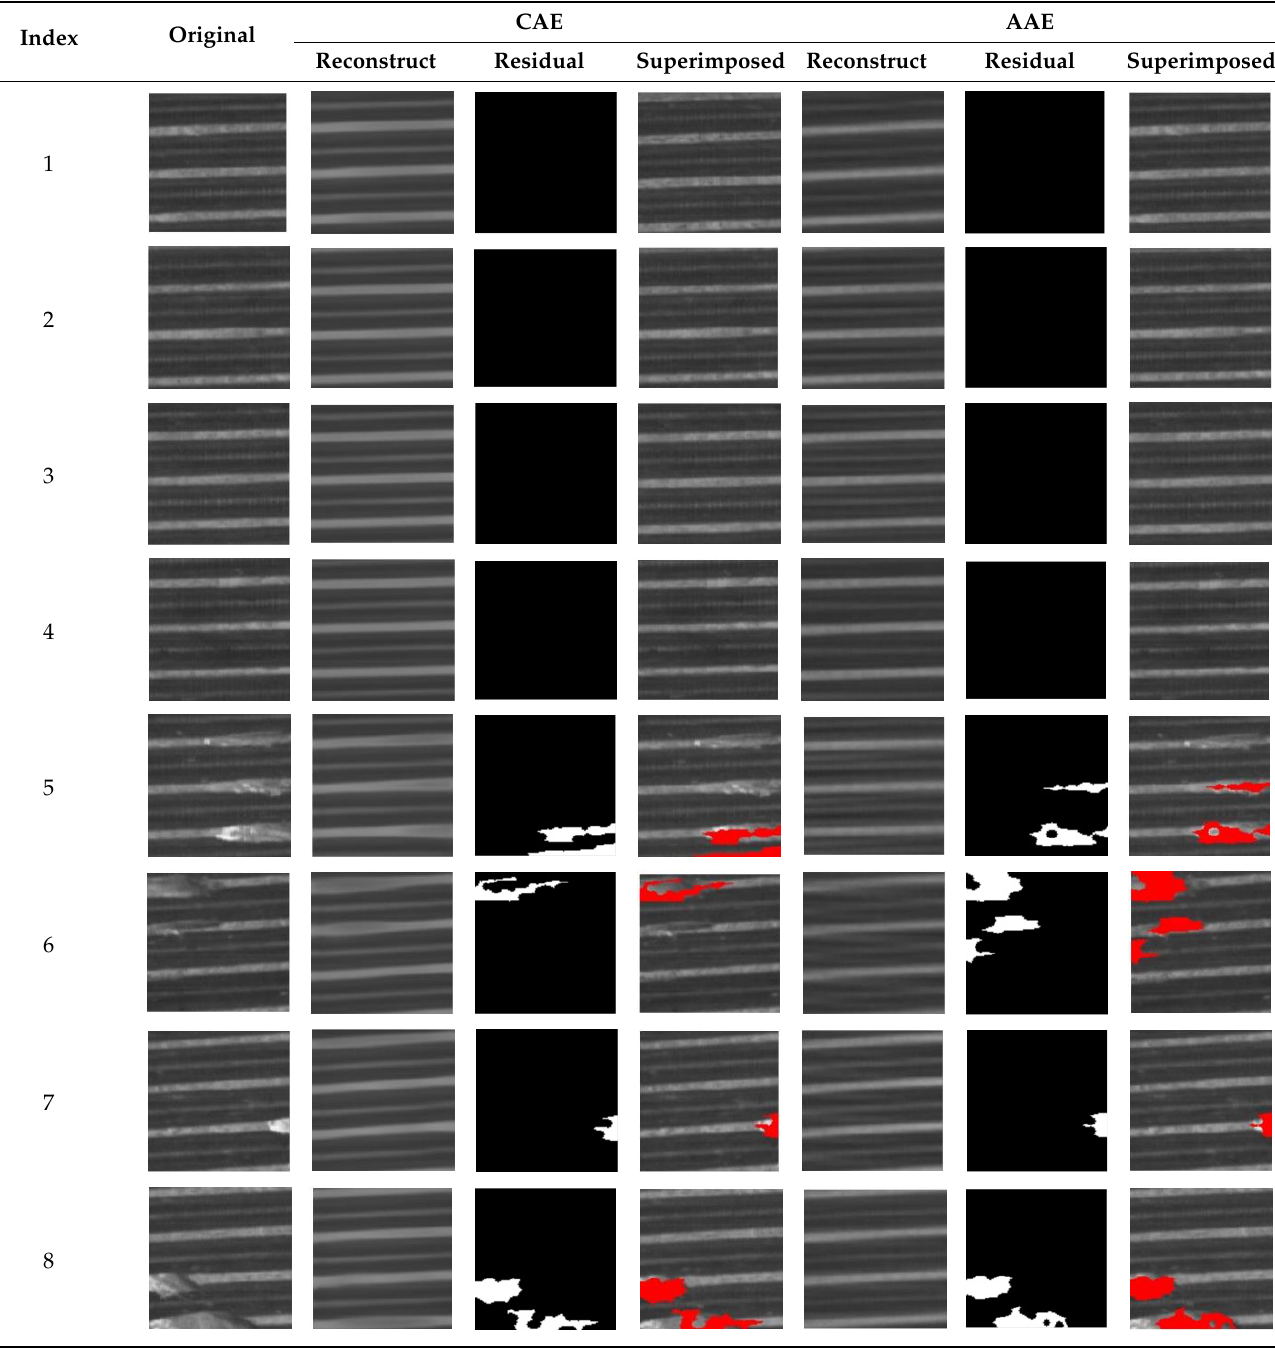
Table 2. The screw patches of dataset 1 tested for CAE and AAE networks (unit: 0.03 mm/pixel).